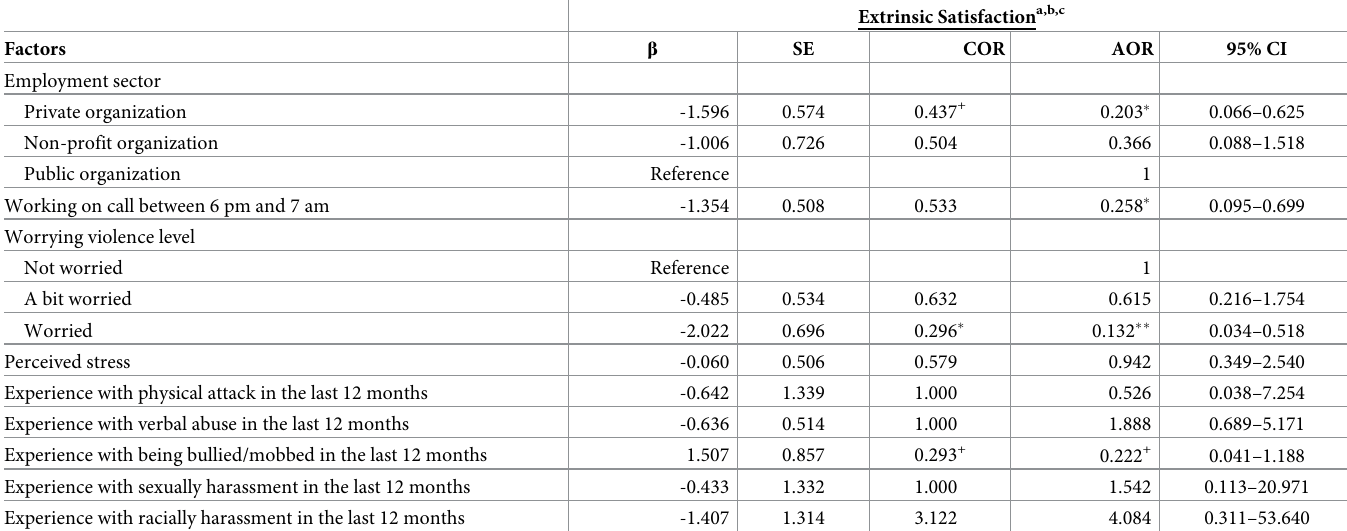
Table 6. Association between risk factors and extrinsic job